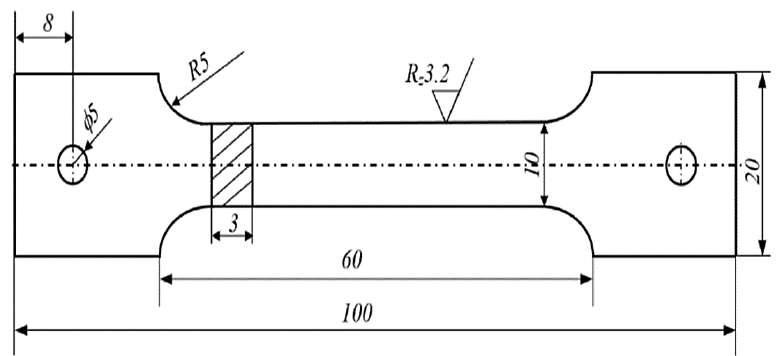
Figure 1. The shape and dimensions of samples for static and stress corrosion tests of the AlMg6 alloy.